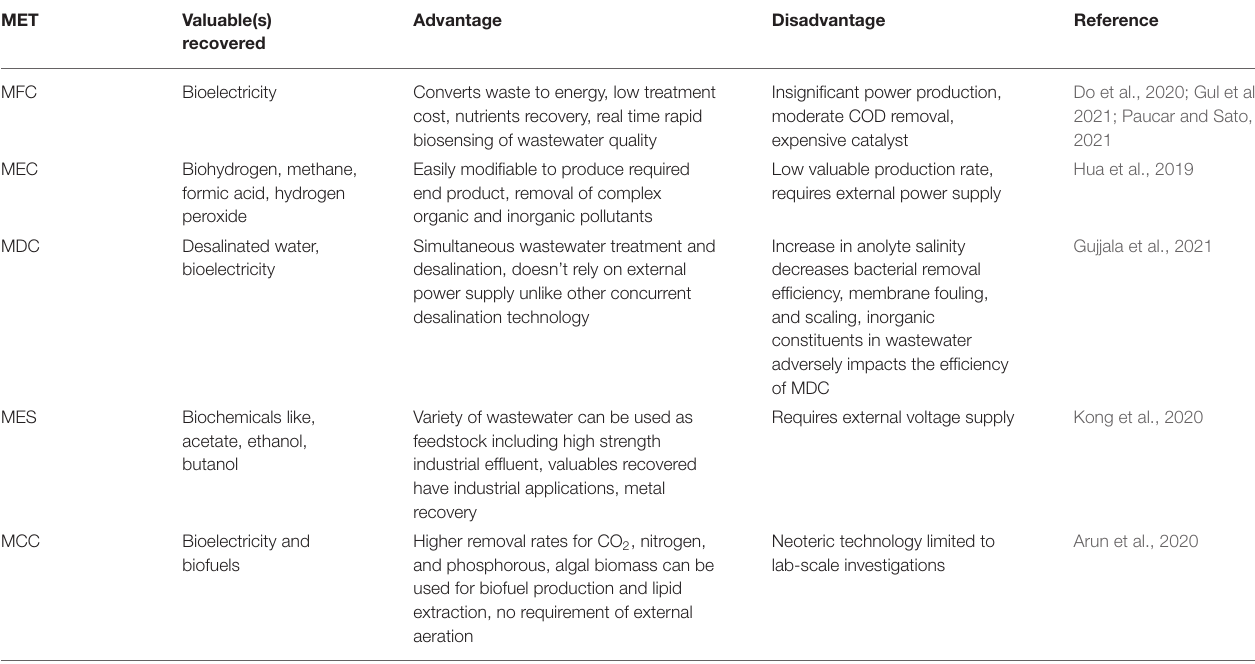
TABLE 1 | Advantages and disadvantages of different microbial electrochemical technologies.